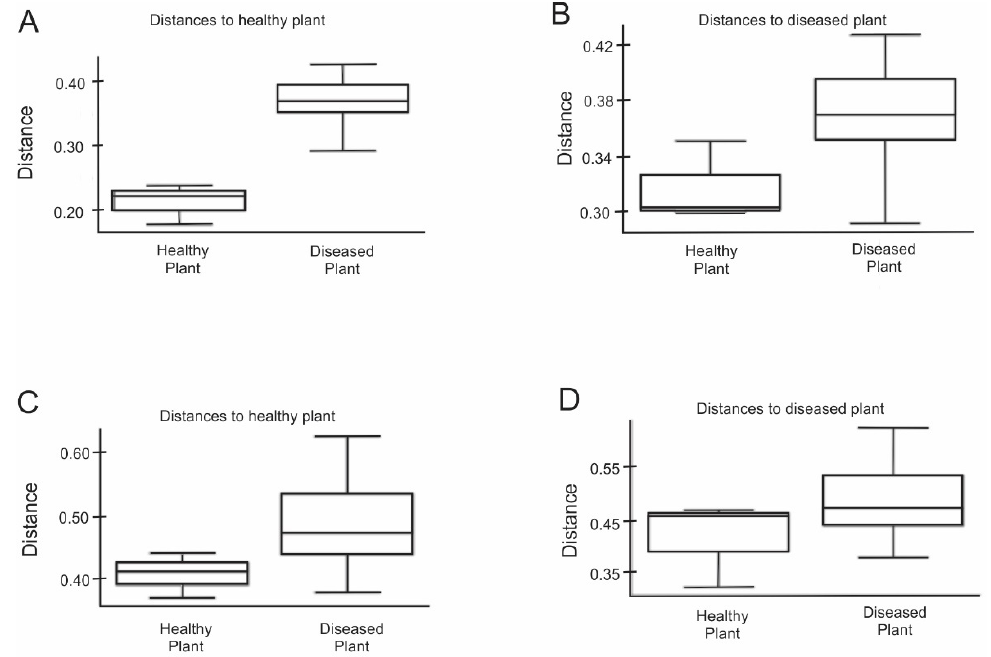
Figure 2. Significant differences in microbial community composition between healthy and diseased rhizosphere micro- biome through UniFrac ANOSIM analysis. ( A ) Unweighted UniFrac distance to healthy plant; ( B ) unweighted UniFrac distance to diseased plant; ( C ) weighted UniFrac distance to healthy plant; ( D ) weighted UniFrac distance to diseased plant. *, ** : sample outlier.